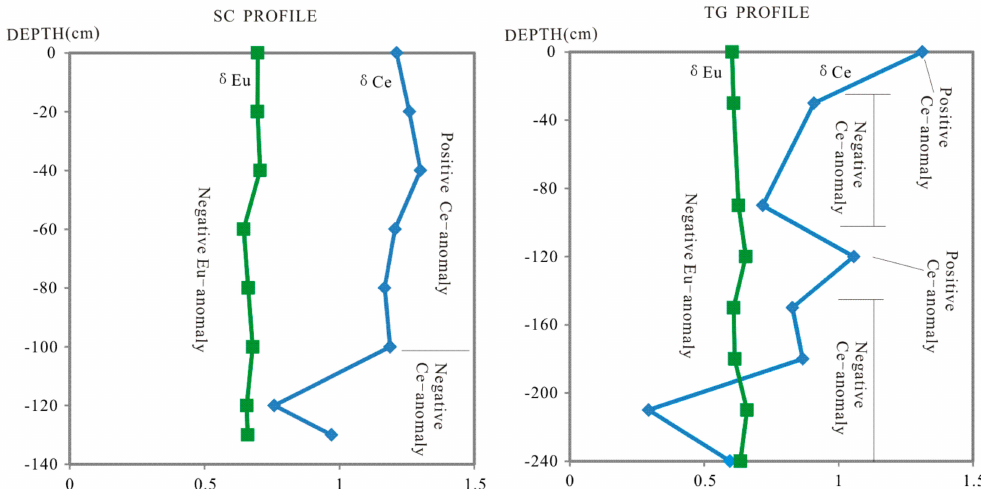
Figure 3. Variation curves of δ Ce and δ Eu with depth in SC and TG profiles. δ Ce > 1 indicates a positive anomaly; δ Ce < 1 indicates negative anomaly. The same applied to Eu.